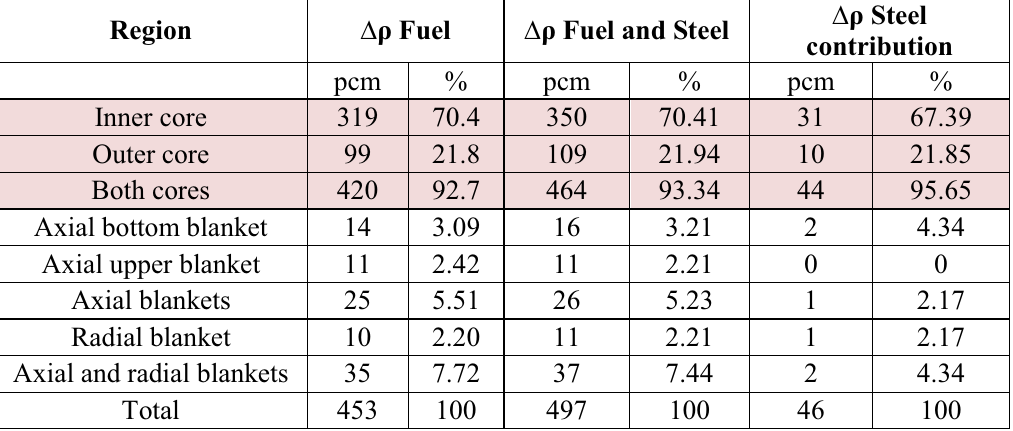
Table IV. Decomposition of the Doppler by mediums for fuel and steel